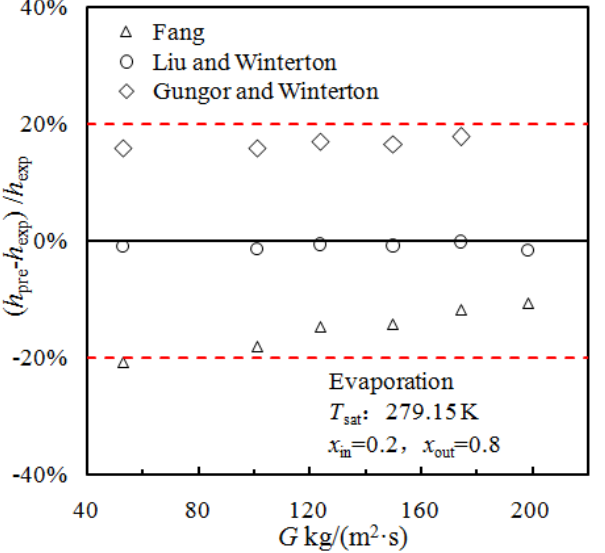
Figure 4. Comparison of deviations from experimental data and values predicted using various smooth tube evaporation correlations.